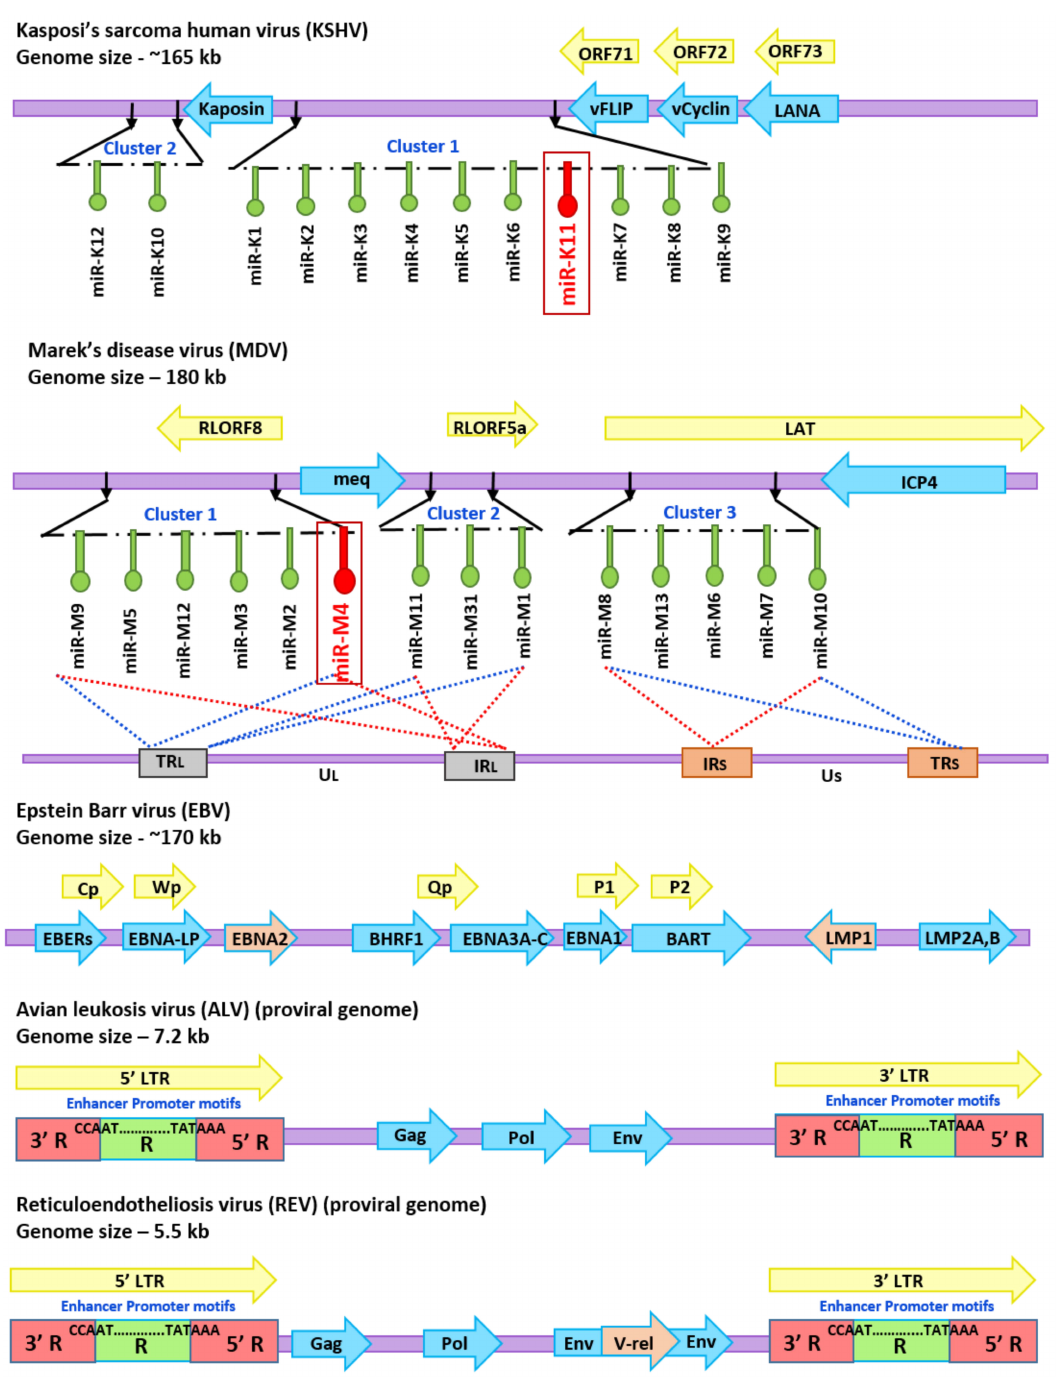
Figure 2. Diagrammatic representation of the genome structure of oncogenic viruses. MDV genome structure showing the locations of Meq and miRNAs including the miR-155 homolog miR-M4. KSHV genome structure with positions of miRNAs including the miR-155 homolog miR-K11 is shown for comparison. EBV genome showing the positions of genes such as EBNA2 and LMP1 that can modulate the expression of miR-155 are shown. Provirus structures of ALV with the 5 (cid:48) and 3 (cid:48) LTR involved in the insertional activation of bic/ miR-155 and REV with the transduced v- rel oncogene are also shown. High level expression of these viral homologs in the infected cells allows KSHV and MDV-1